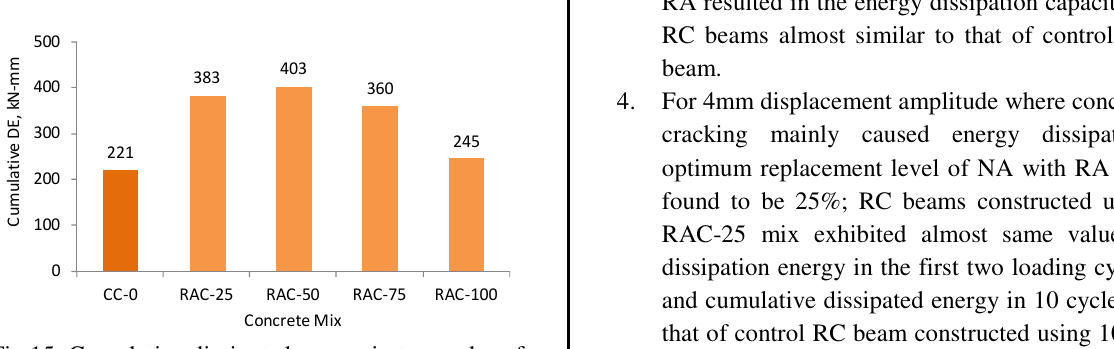
Fig.14: Cumulative dissipated energy in ten cycles of 4mm amplitude